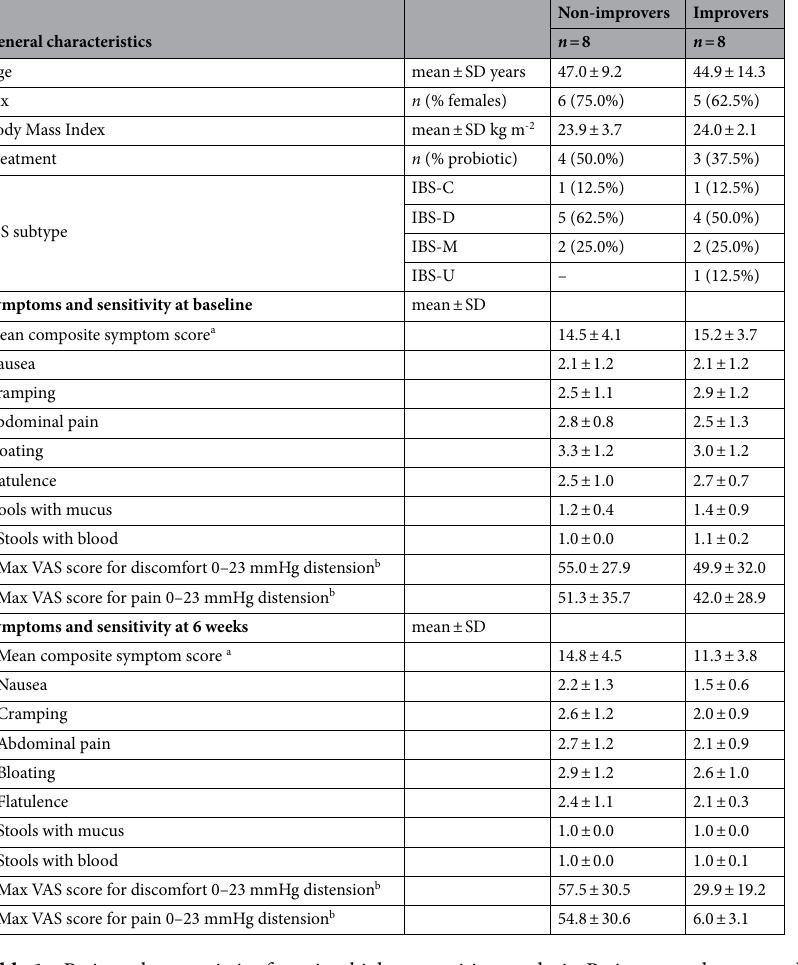
Table 1. Patient characteristics for microbial composition analysis. Patient samples were selected from a previous clinical trial 17 . At baseline, all patients were diagnosed as hypersensitive to colorectal distension. Patients are separated based on improvers vs. non-improvers, referring to a change of sensitivity status to normosensitive or remaining hypersensitive. BMI body mass index, BM bowel movements. IBS subtypes U, C, D, M unspecified, constipation, diarrhea, mixed defecation pattern. a composite score calculated based on mean of 7 subjects scored on a 5-point Likert scale from 1 to 5 (i.e. nausea, cramping, abdominal pain, bloating, flatulence, stools with mucus, stools with blood) for 14 days. Composite score range 7–35. b Maximum VAS